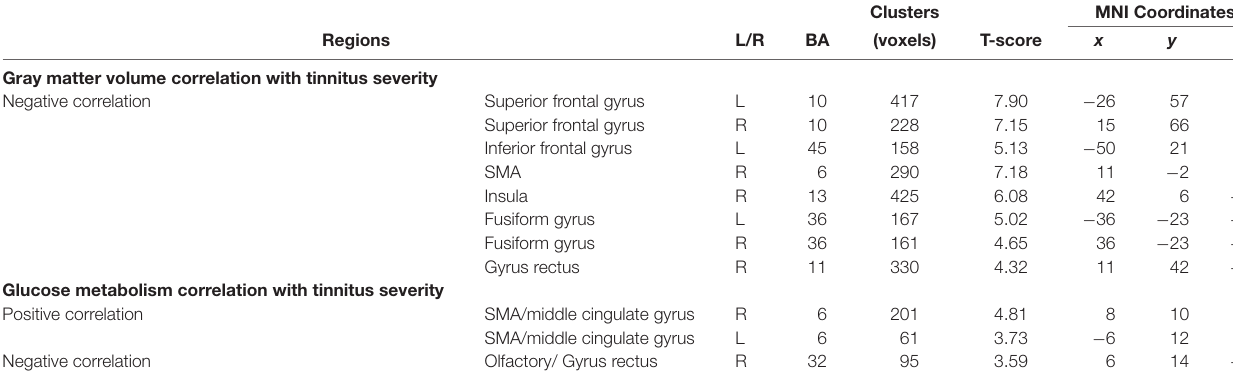
TABLE 3 | Correlation analysis between glucose metabolism or gray matter volume and tinnitus severity in MCI_T group.